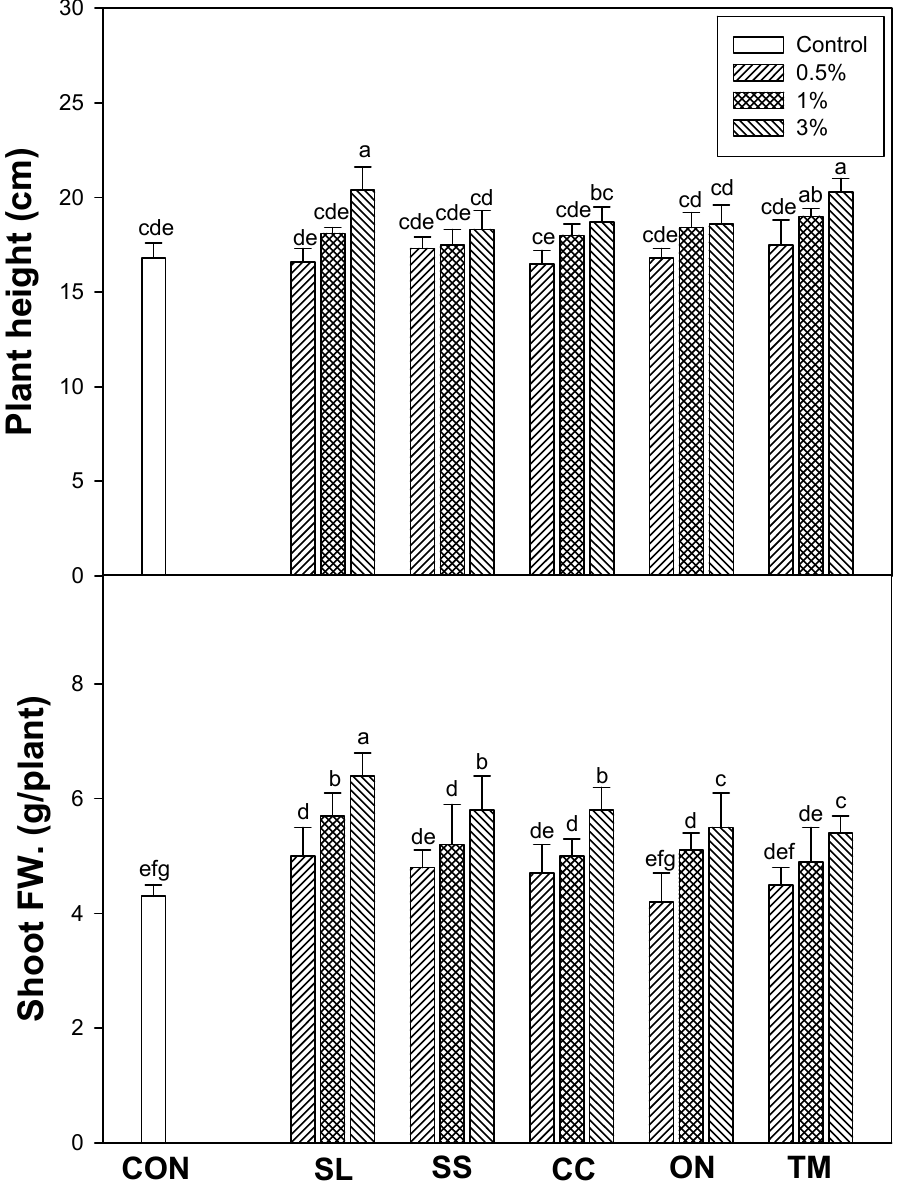
Figure 1. Effect of various plant extracts (SL, soybean leaf; SS, soybean stem; CC, Chinese chive, ON, onion; TM, tomato) on plant height and shoot fresh weight of Peucedanum japonicum. Means within bars followed by the same letters are not significantly different at the 5% level according to Duncan’s Multiple Range Test.